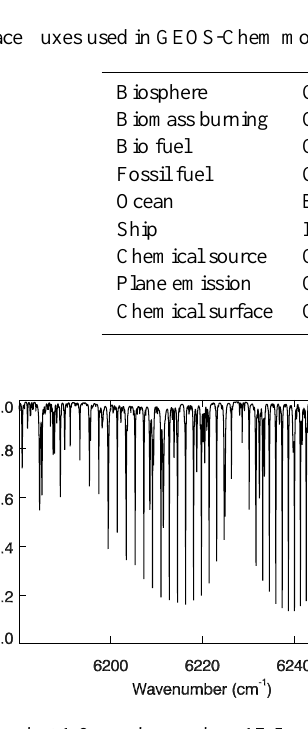
Fig. 2. CO 2 band at 1.6µm observed on 17 June 2008 by TCCON at Park Falls (Wisconsin) with solar zenith angle of 22.5 ◦